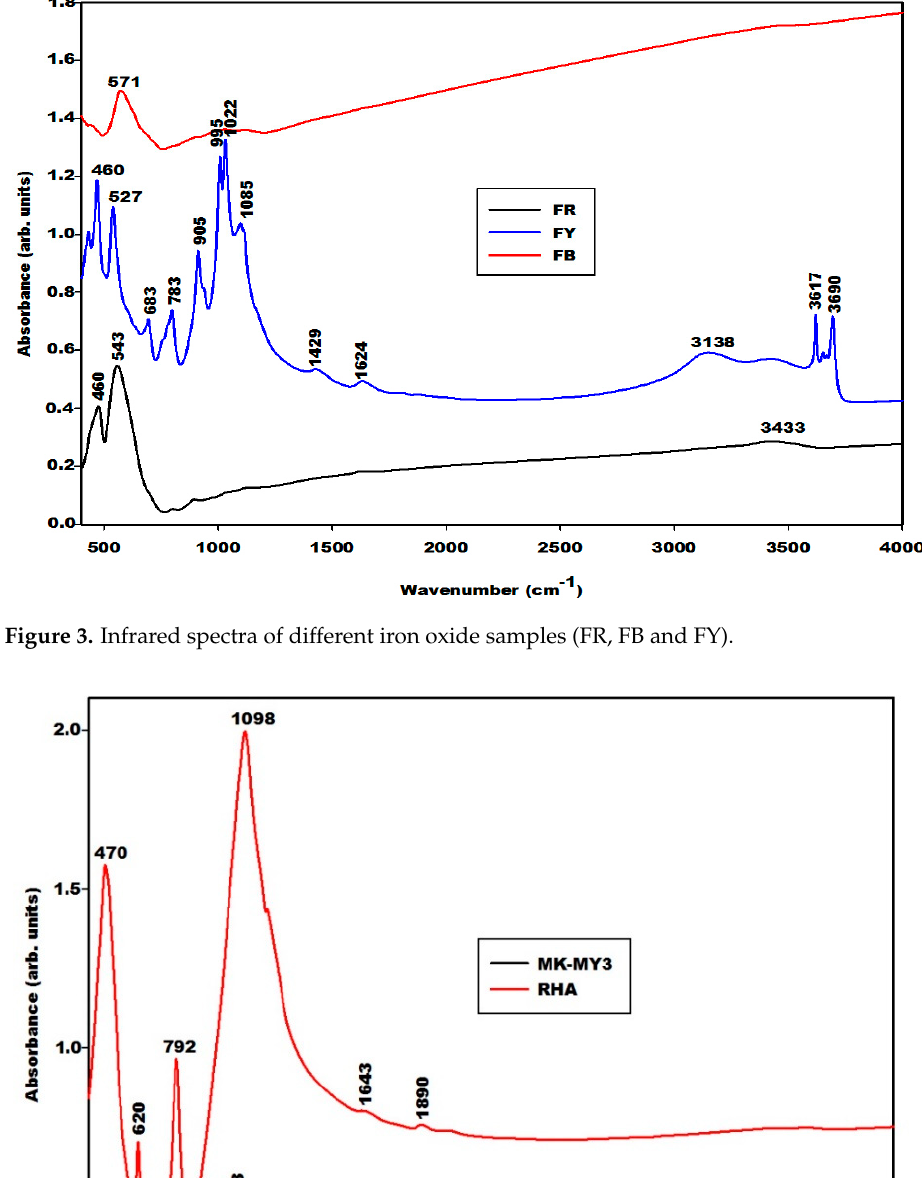
Figure 3. Infrared spectra of different iron oxide samples (FR, FB and FY).